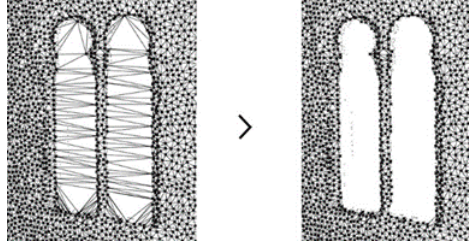
Figure 9. Processed Delaunay mesh of windows.